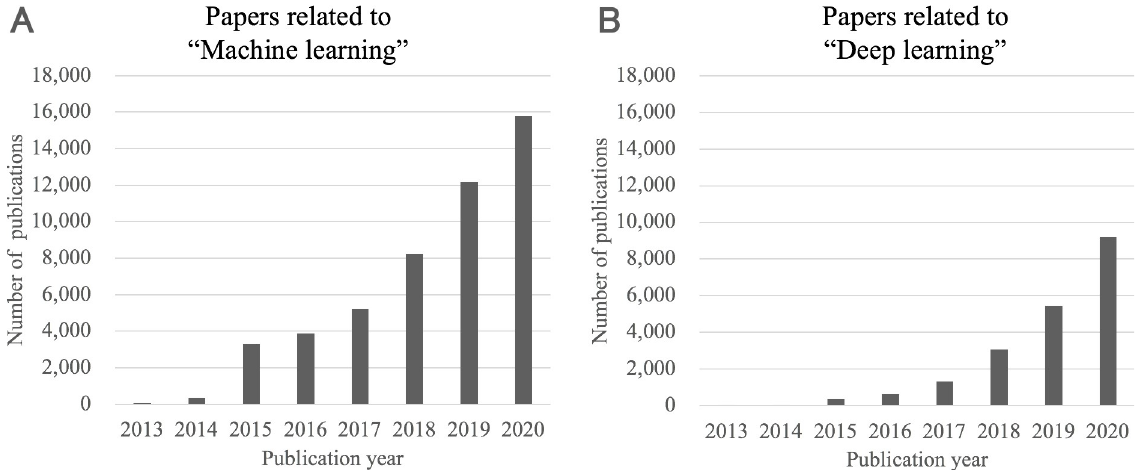
Fig 1. Transition of the number of publications regarding machine learning or deep learning in PubMed. (A) Transition of the number of machine-learning-related publications. The search query was (Machine learning) AND (("2015/1/1"[Date—Publication]: "2020/12/31"[Date— Publication])) (accessed at 2, February, 2021). (B) Transition of the number of deep-learning-related publications. The search query was (Deep learning) AND (("2015/1/1"[Date—Publication]: "2020/12/31"[Date—Publication])) (accessed at 2, February, 2021). Publications regarding machine learning or deep learning are rapidly increasing in